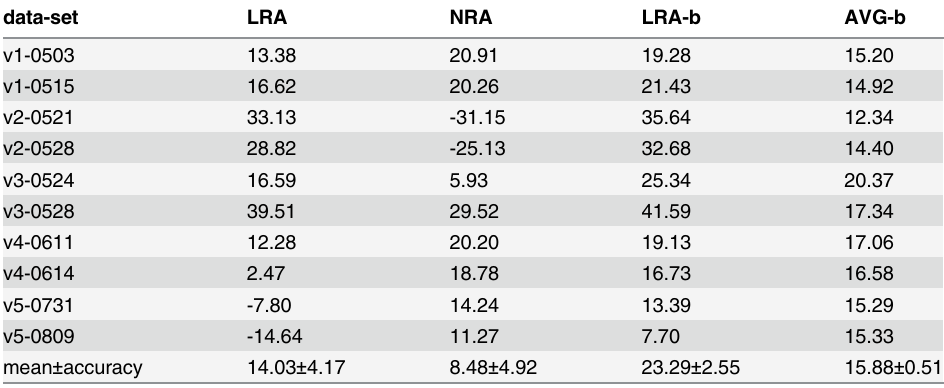
Table 2. Difference in the width of ADC histogram Δ σ D between results obtained using AVG and those obtained using each of the alternative methods on protocol B data (using Table 1); same units as ADC (10 − 5 mm 2 / s ); the bottom row gives the mean of Δ σ D values for each method and its corresponding